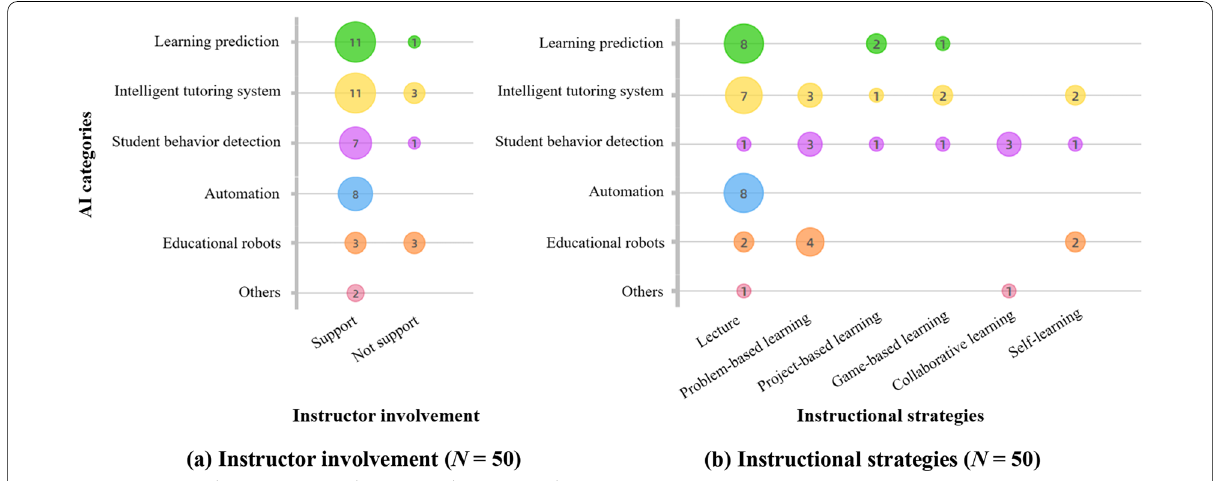
Fig. 7 AI categories under instructor involvement and instructional strategies